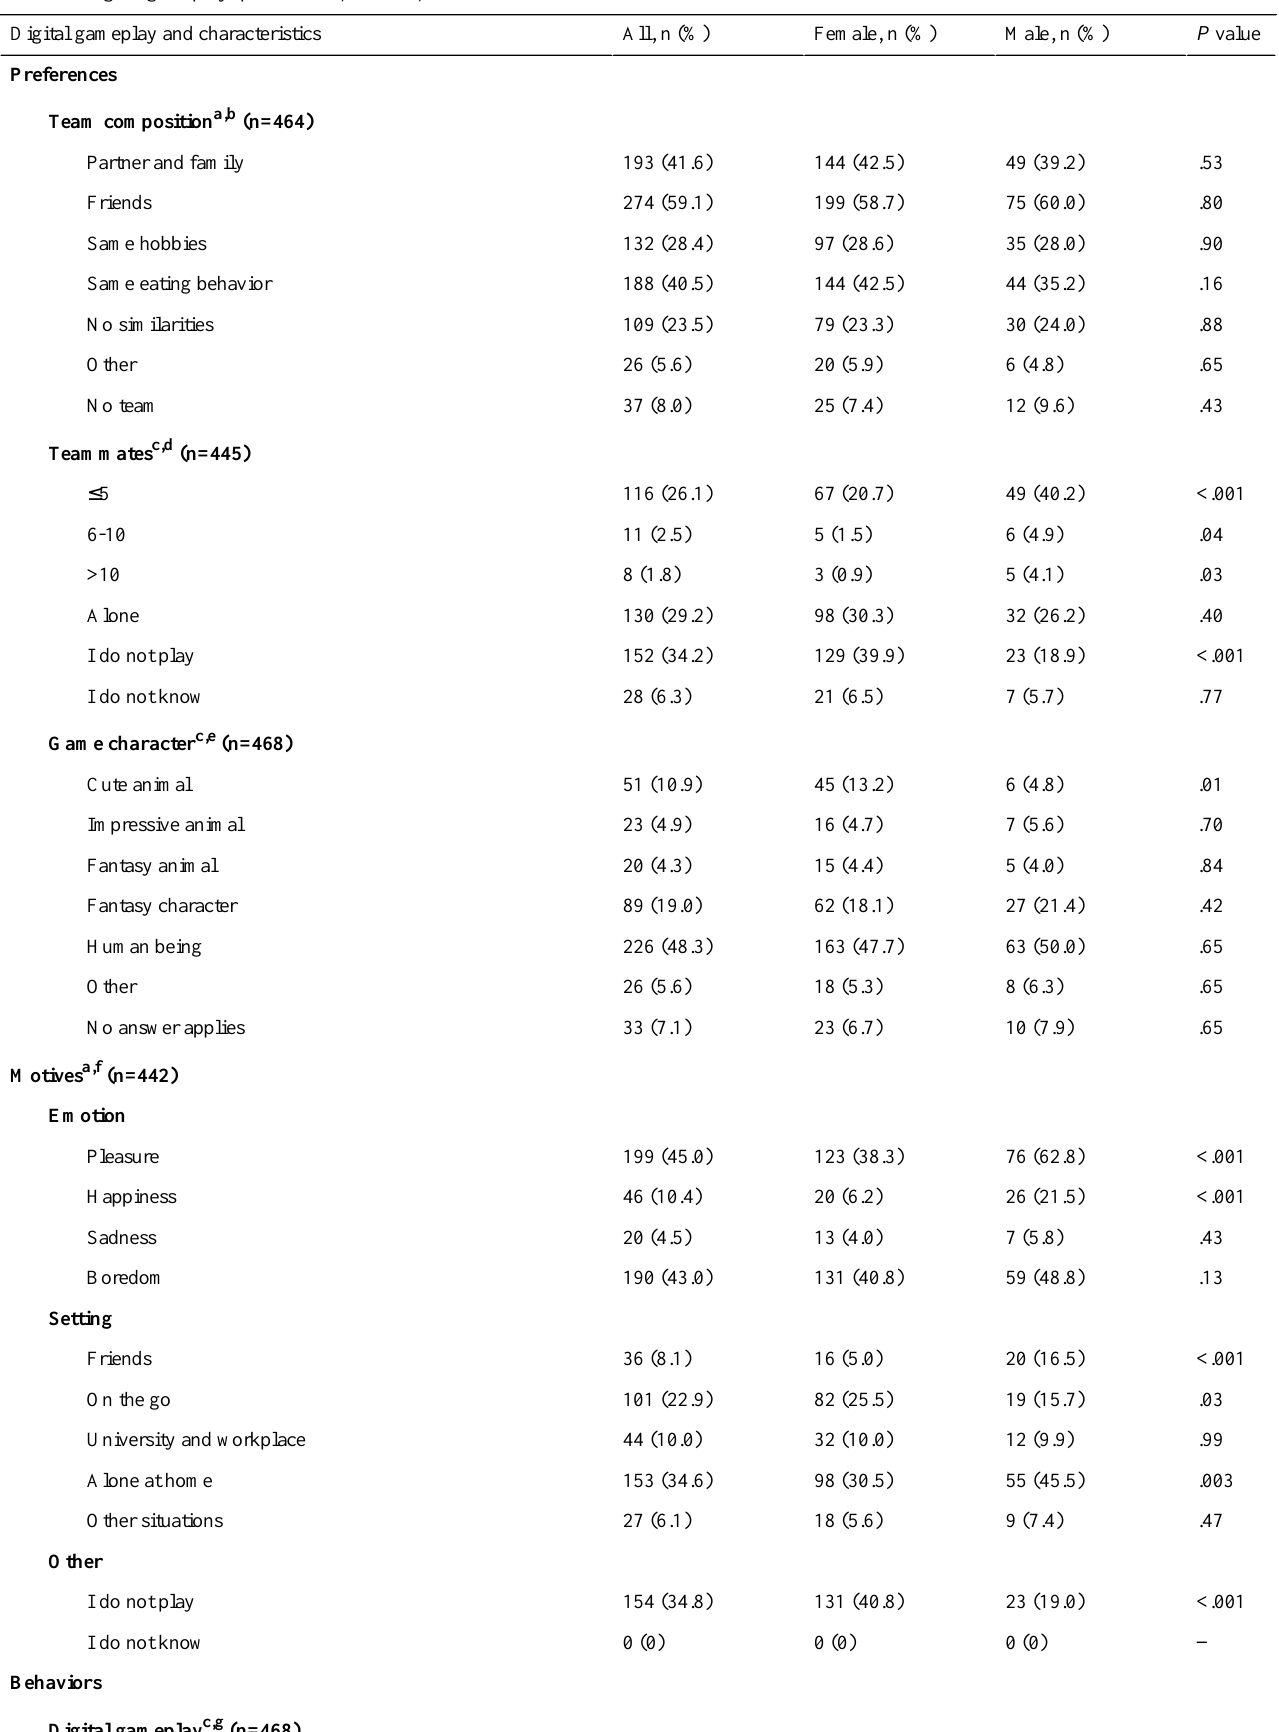
Table 3. Digital gameplay: preferences, motives, and